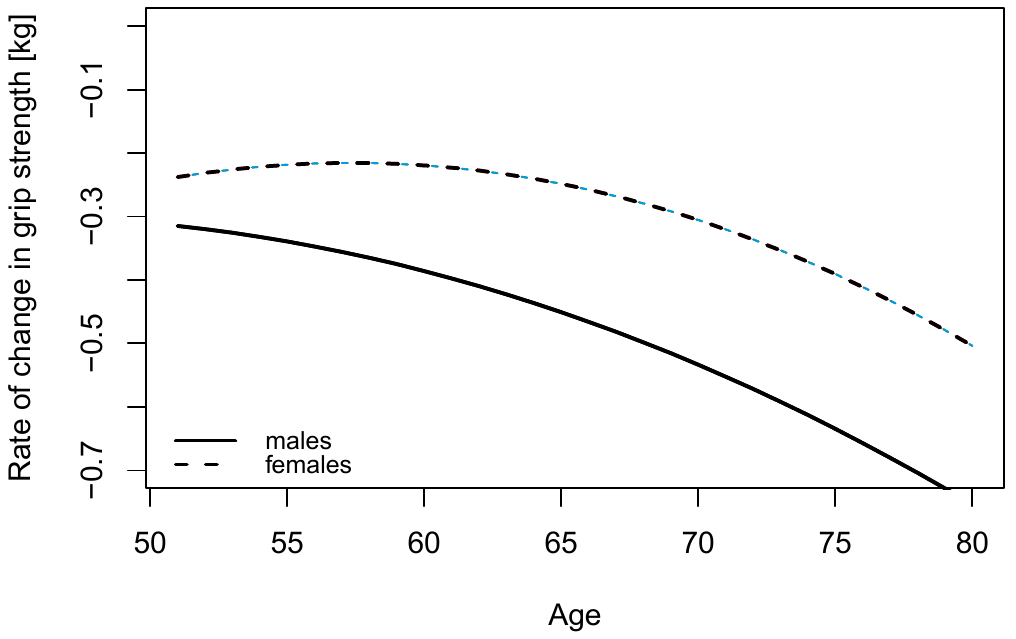
Figure 2. Rate of change in grip strength by age for males and females at median height and weight, engaged in vigorous physical activity at least once a week.